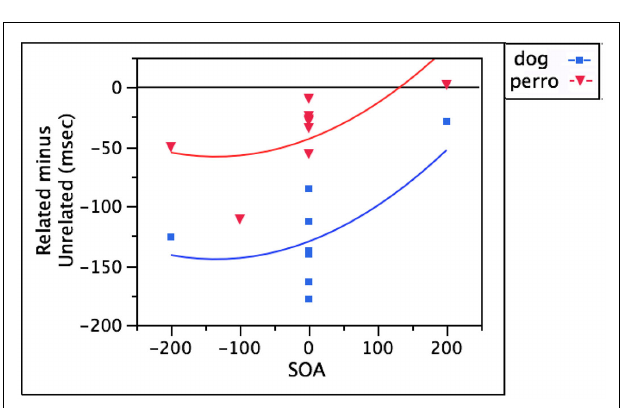
FIGURE 2 | Stronger facilitation for target than target-translation